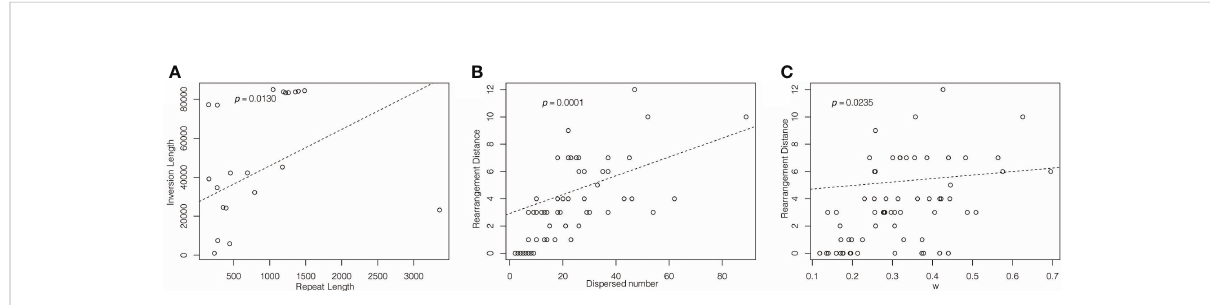
FIGURE 3 PGLS analysis of (A) dispersed repeat length and inversion length; (B) dispersed repeat number and rearrangement distance; (C) rearrangement distance and w